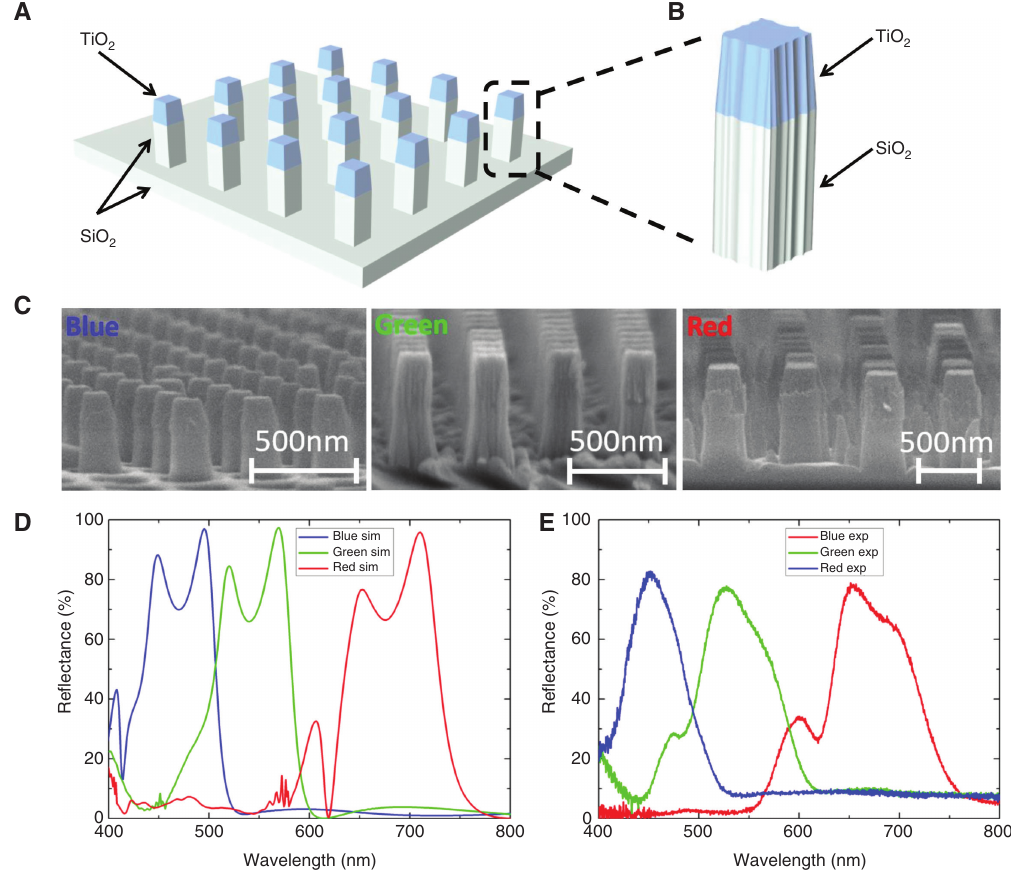
Figure 1: All-dielectric metasurfaces for visible light range applications. (A) Schematic of the ideal all-dielectric metasurface. The nanopillar is a frustum with smooth surfaces. (B) Schematic of the fabricated all-dielectric metasurface. The surfaces of nanopillar are rough. (C) SEM images of fabricated band reflector based on all-dielectric metasurfaces for blue, green, and red light, respectively. (D) Calculated reflection spectra of the ideal all-dielectric metasurfaces (A). (E) Measured reflection spectra of the fabricated all-dielectric metasurfaces (C), which are obviously different from the calculated